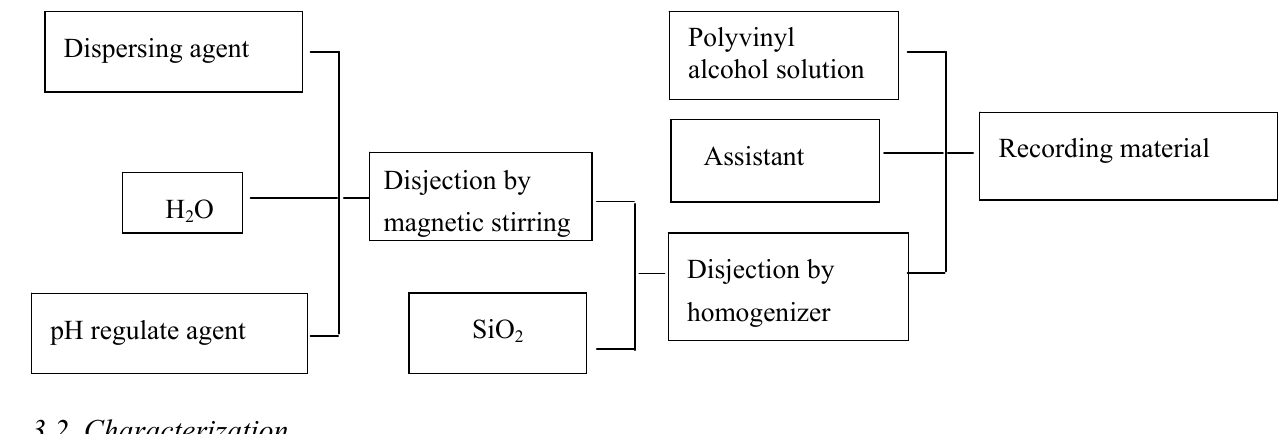
Figure 6. Preparation process of the recording